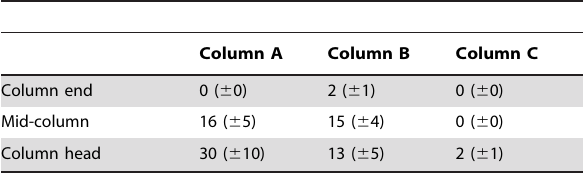
Table 1. The average number of dengue viruses that were observed in the SEM